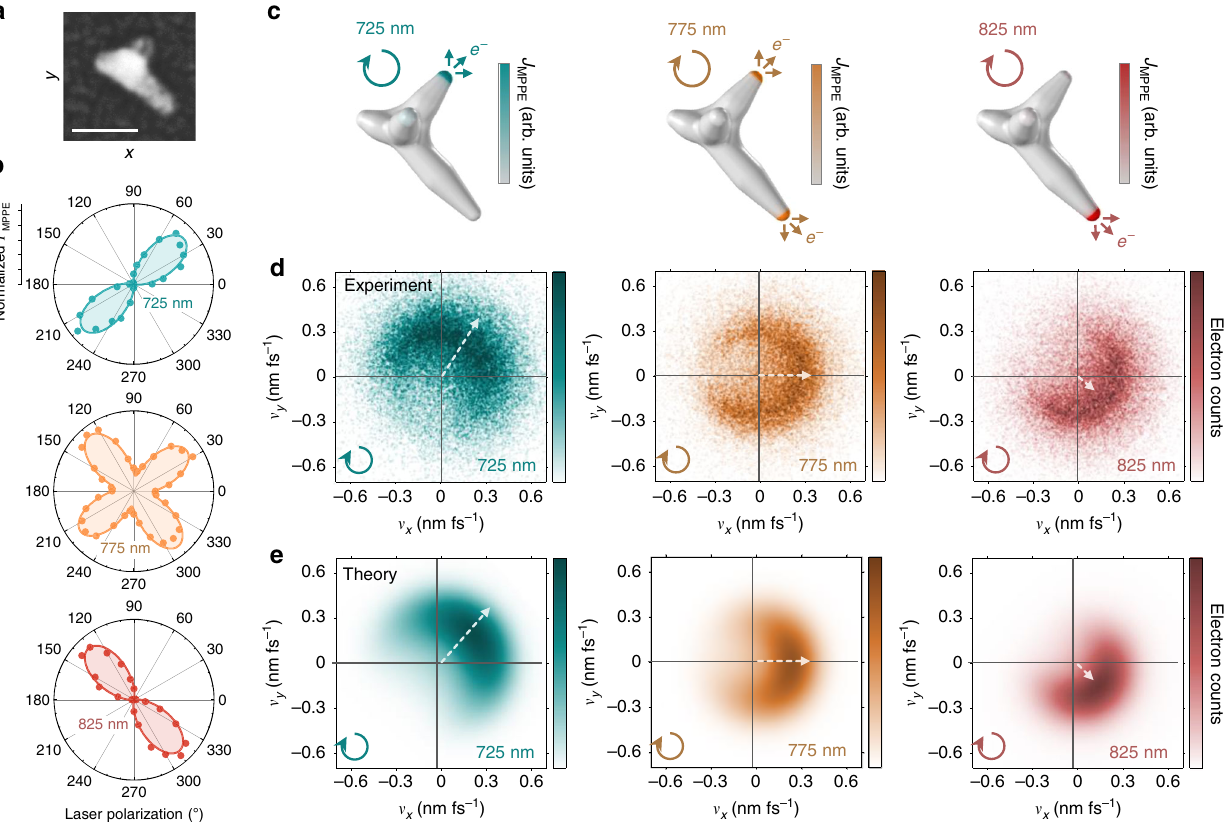
Fig. 4 Frequency-controlled directional photoemission. a Correlated nanostar scanning electron micrograph with the shorter and longer resonant tips at 50° and 315°, respectively (50 nm scale bar). b Experimental polarization dependence for frequency at the short-tip resonance (725 nm, blue), between resonances (775 nm, orange), and at the long-tip resonance (825 nm, red) with nonlinear cosine fi ts for the 3-photon process. c Calculated multiphoton surface current distribution at different frequencies, showing the transition from one tip hot spot to the other with circular polarization. d Experimental and e theoretical v z -projected velocity maps on and between the two resonances using circular polarization. Vectors indicate the peak directions determined by Gaussian fi ts around the peaks of the angular distributions. Peak photoemission angles range from 55° (50°) at 725 nm to 325° (315°) at 825 nm for the experimental (theoretical) velocity distributions, i.e. a 90° photoemission rotation. The vector magnitude represents the speed ( v F ) of photoelectrons excited from the Fermi level, which decreases with decreasing photon energy by energy conservation, 1 and n = 3 in this excitation energy range ( (cid:1) h ω ¼ 1.5 – 1.7 eV). The Fermi velocity does not coincide with the apparent edge of the 825 nm (red) distribution due to the velocity dependence of the photoemission amplitude, which leads to deviations from a simple Fermi – Dirac distribution (particularly near-zero velocity) and shifts the effective edge outward relative to v F for near-threshold photon